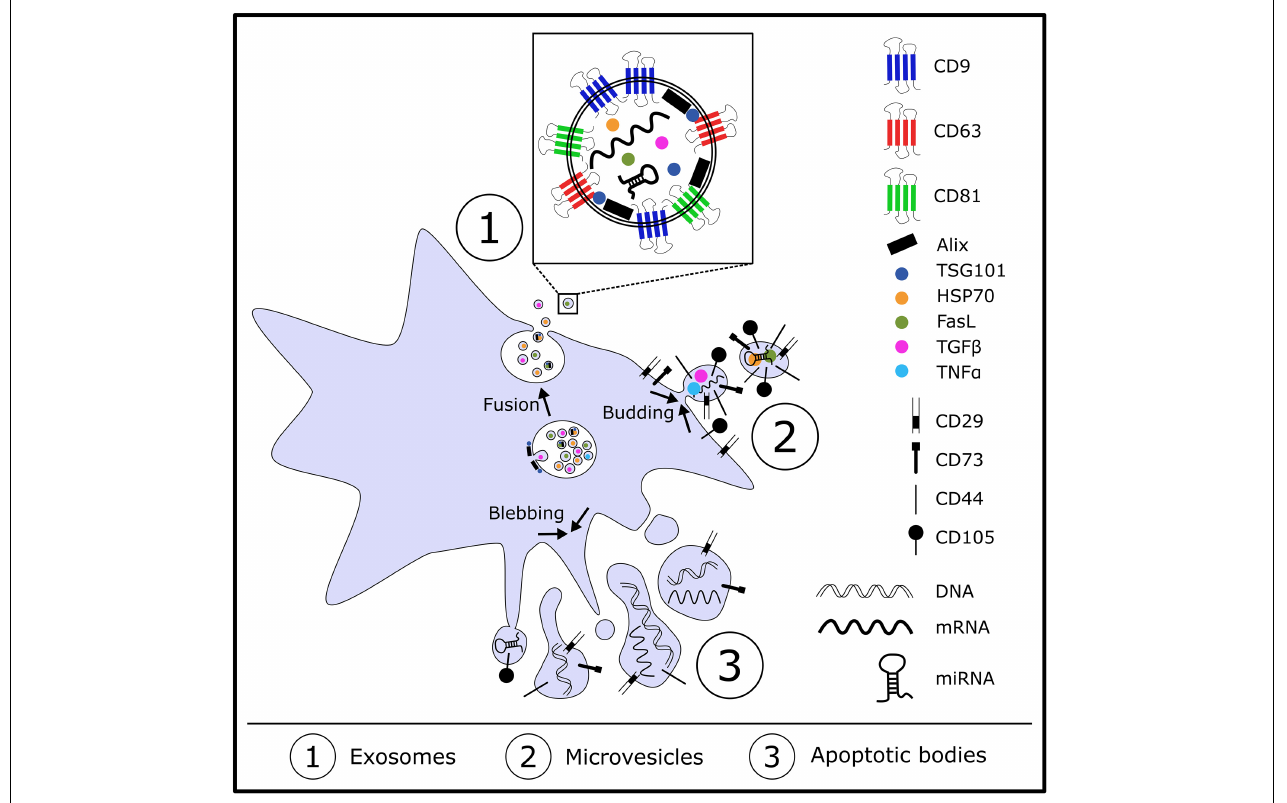
FIGURE 1 | Overview of the biogenesis of exosomes, microvesicles and apoptotic